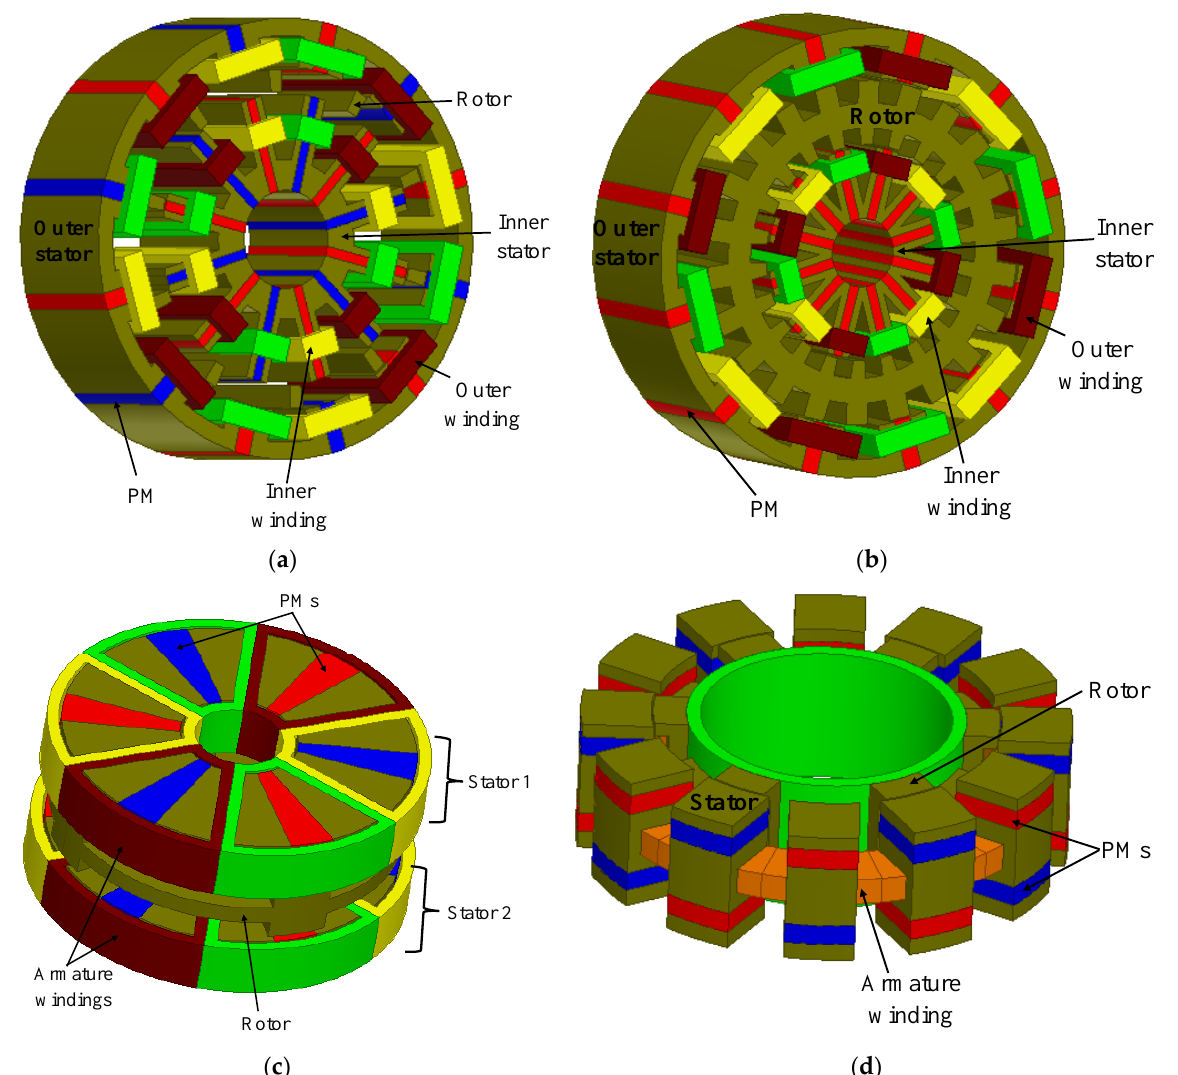
Figure 15. Emerging designs of flux switching stator mounted machines: ( a ) double-stator flux switching motor; ( b ) double-stator flux switching motor with doubly salient rotor; ( c ) axial field flux switching motor; ( d ) transverse flux switching motor.